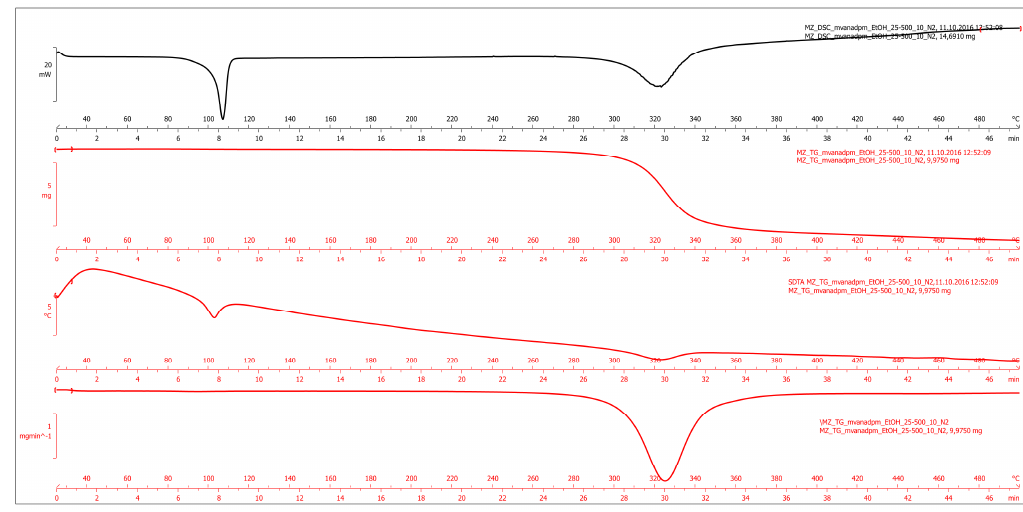
Figure C5. DSC, TG, SDTA and DTG curves of mvanadpm .